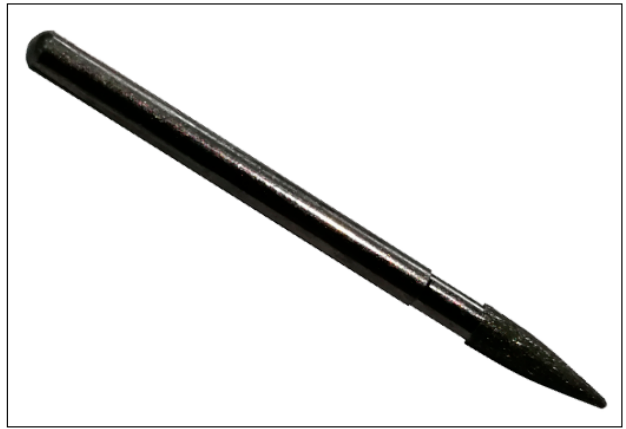
Figure 40. Experimental tool.